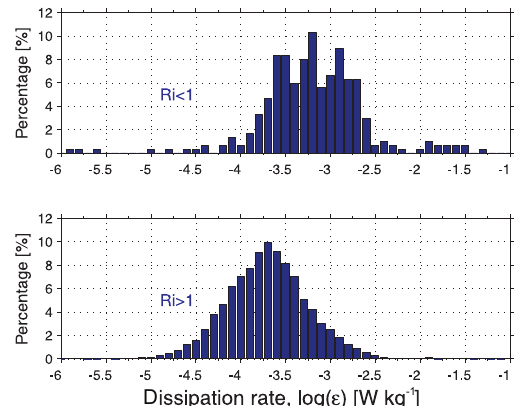
Figure 11. Histograms of energy dissipation rates ε derived from the radar measurements with MAARSY in the years of 2010–2013 under the conditions of Ri < 1 (upper panel) and Ri > 1 (lower panel), respectively.